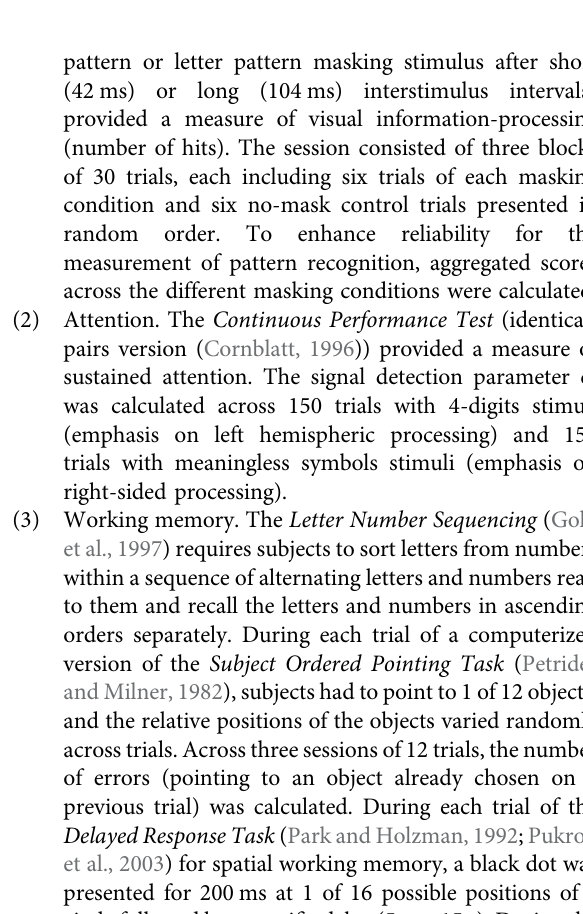
FIGURE 1 | CONSORT fl ow diagram (Leweke et al., 2012). Analyses sets: VfS, valid for safety; mITT, modi fi ed intention-to-treat and PP, per